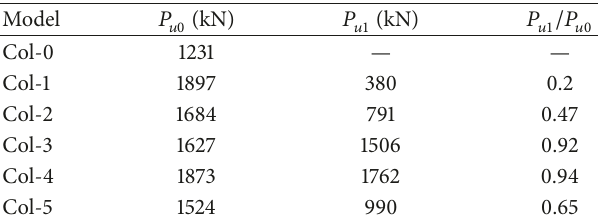
Table 3: Failure loads of the